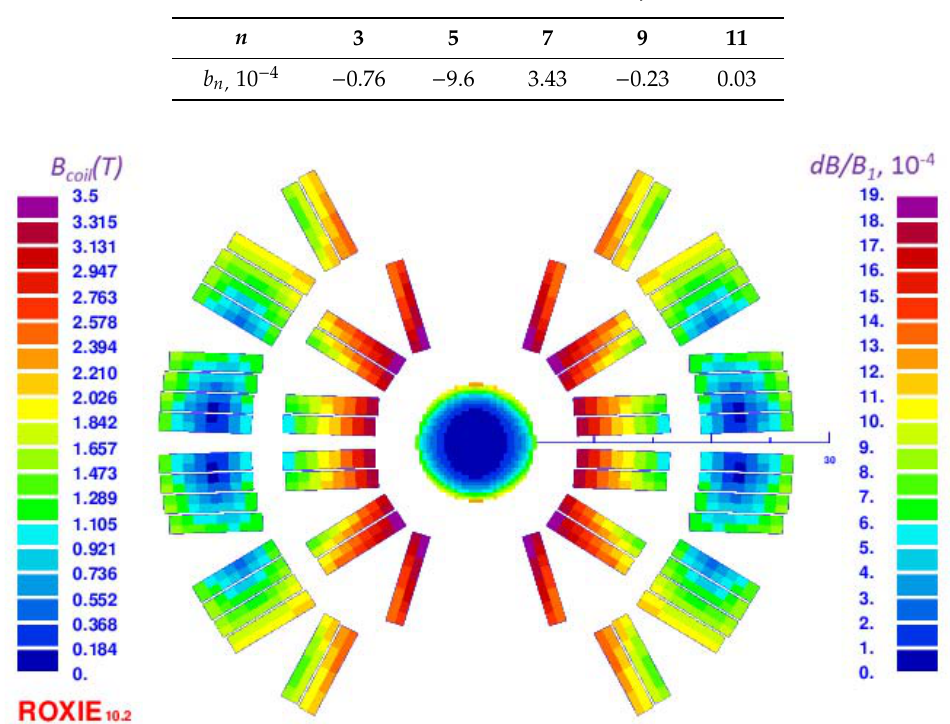
Table 3. Geometrical field harmonics at R ref = 5 mm.